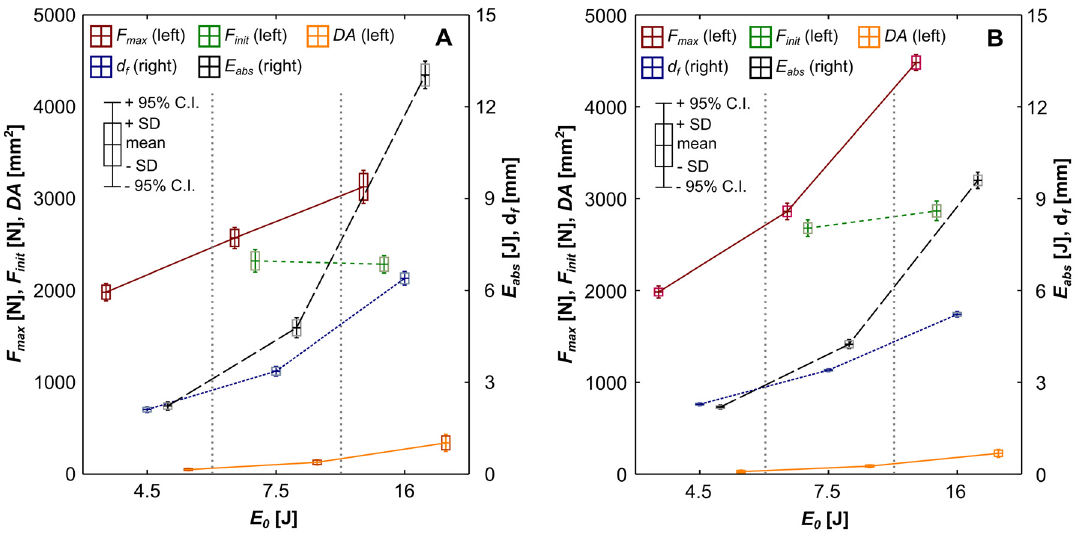
Figure 3. Physical parameters of low-velocity-impact phenomenon for ACL ( A ) and AGL ( B ). The values of maximal impact force ( F max ), force of damage initiation ( F (cid:3036)(cid:3041)(cid:3036)(cid:3047) (cid:4667) , damaged area (DA), permanent deflection of plate ( d f ) and absorbed energy ( E abs ) are shown as box plots to simplify statistical